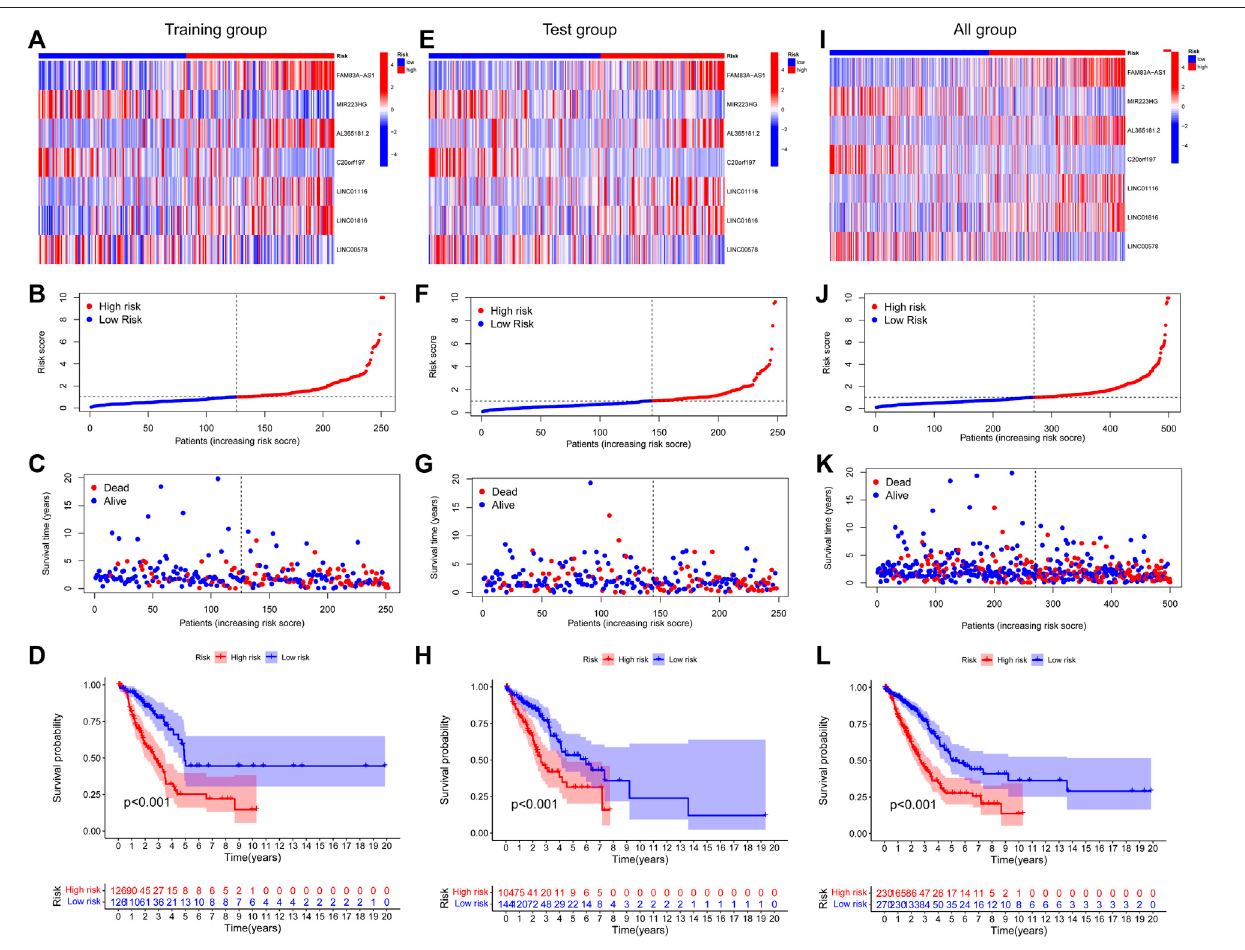
FIGURE3| PrognosticvalueofriskpatternsofsevenFAM-associatedlncRNAs. (A,EandI) Traininggroup, testgroup, andwholegroupclusteranalysisheatmap showingtheexpressionlevelsofsevenprognosticfactorsperpatient. (B) FandJ,distributionofriskscoresforthetraininggroup,testgroup,andwholegroupbasedon theFAM-associatedlncRNAsmodel. (C,GandK) Differencesinsurvivalstatusandsurvivaltimepatternsbetweenthetraining,test, andwholegroupsofhigh-andlow- risk groups. (D,H and L) K – M survival curves for OS in the training group, test group, and the entire cohort of patients in the high- and low-risk groups.